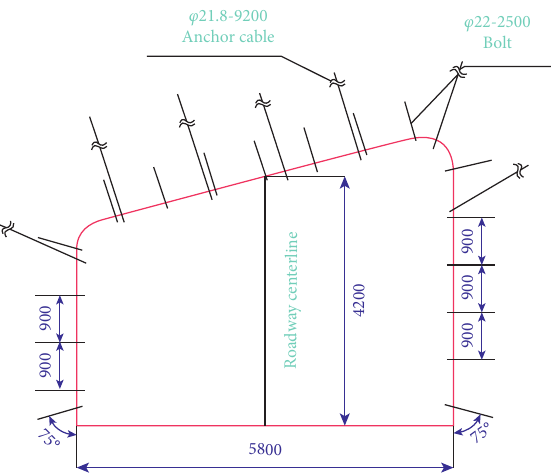
Figure 11: Roadway section support layout.